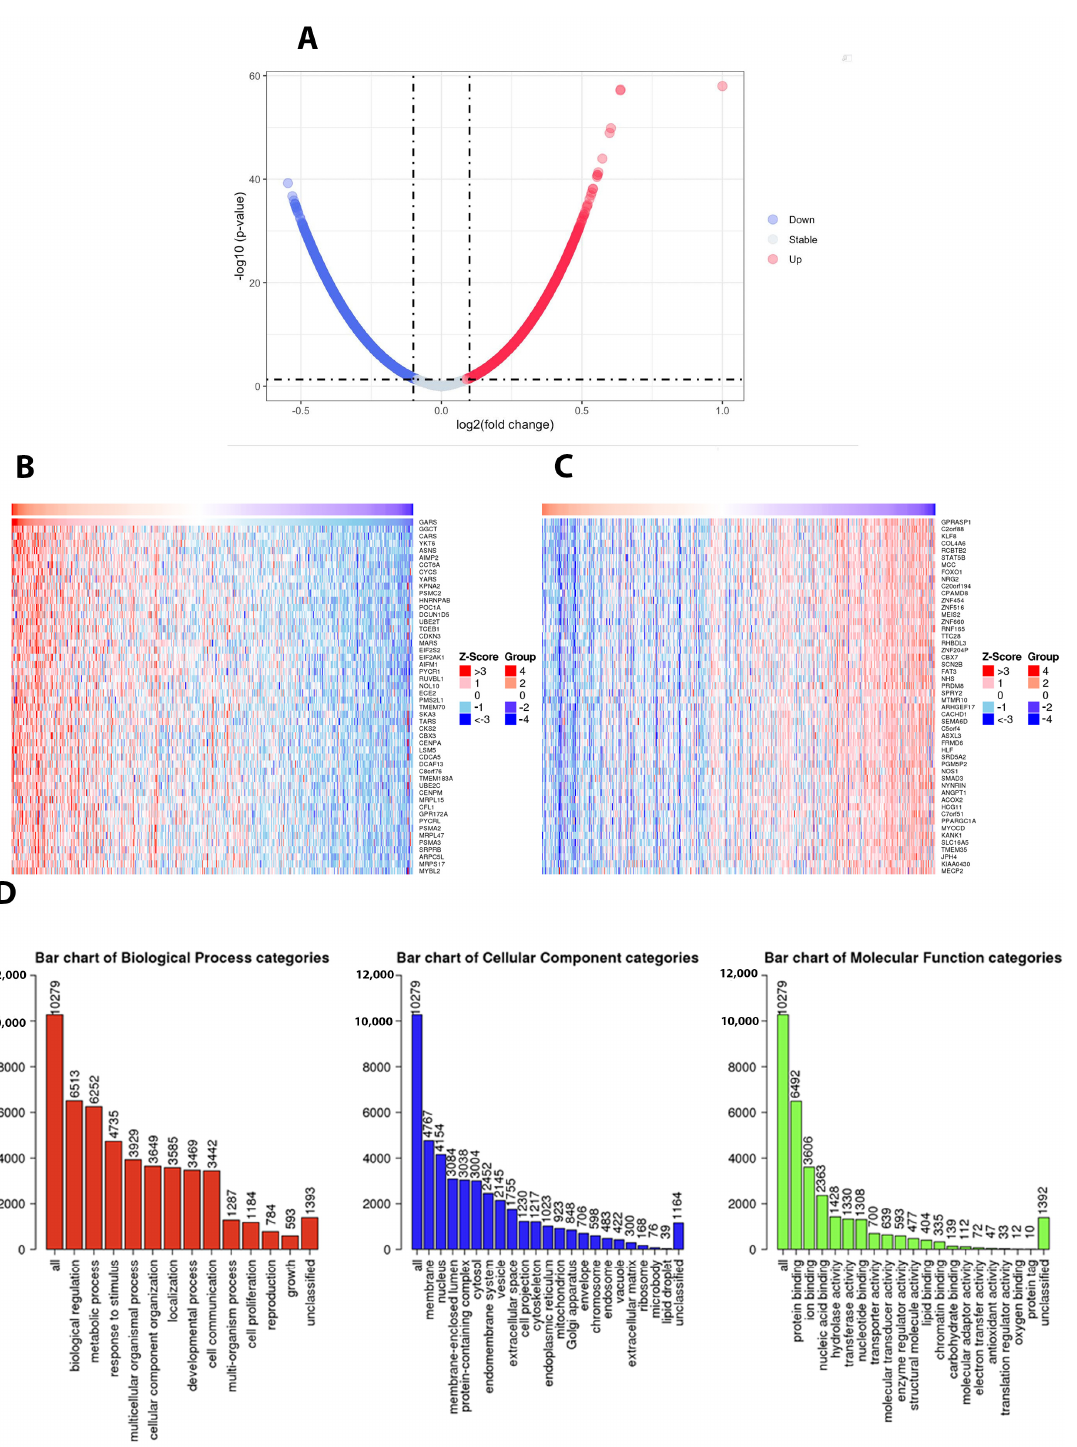
Figure 5. GARS Gene Set Enrichment Analysis in PCa TCGA PRAD . ( A ) Volcano blot showing the differentially expressed genes associated with GARS. Downregulated genes (blue), unchanged genes (grey), upregulated genes (red). The horizontal dashed line represents the Log2 threshold. ( B ) Heatmaps indicating the top 50 positively correlated genes. ( C ) The top 50 negatively correlated genes in relation to GARS overexpression. ( D ) Bar blots indicating the GSEA analysis categories, including biological functions (Red), cellular components (Blue), and molecular functions (Green). FDR was calculated using the Benjamini–Hochberg test, and height of the bar indicated the number of IDs in the user